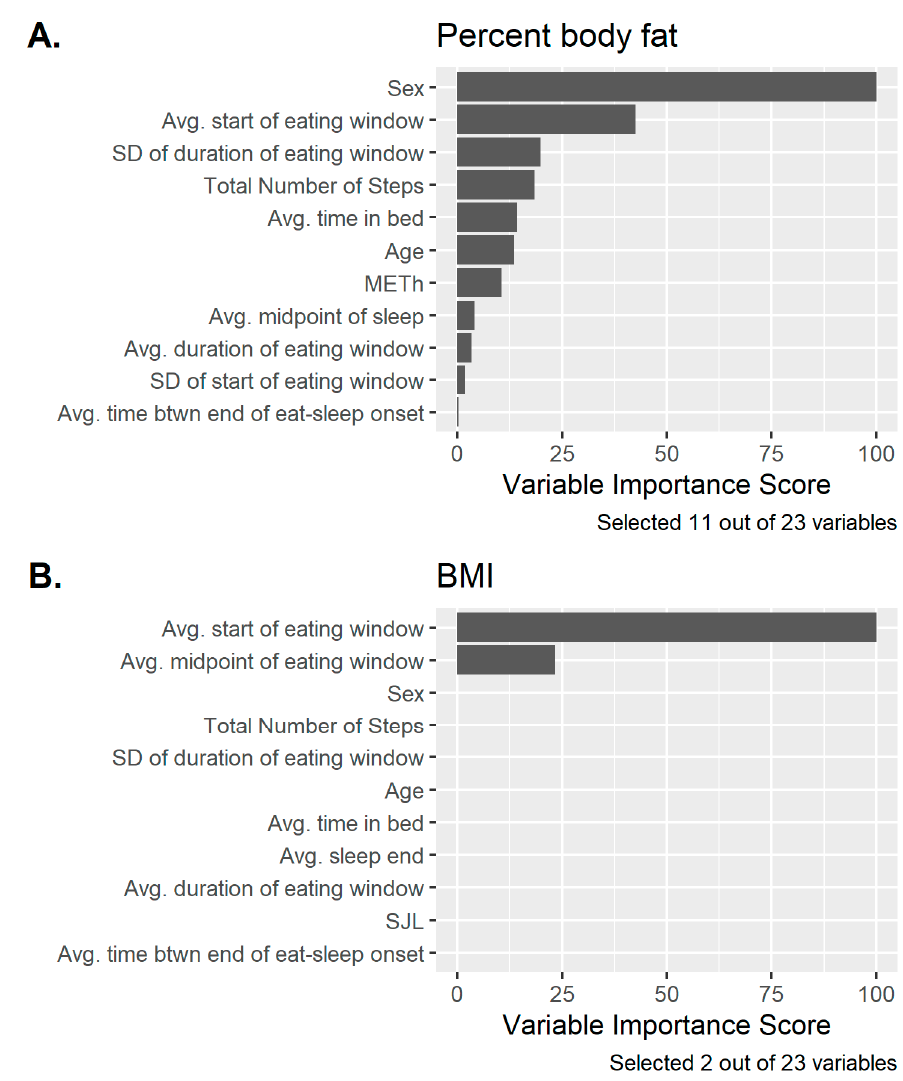
Figure 4. Elastic Net variable selection results showing the highest ranking meal timing, sleep, and physical activity variables as they relate to body fat percentage ( A ) and BMI ( B ) .